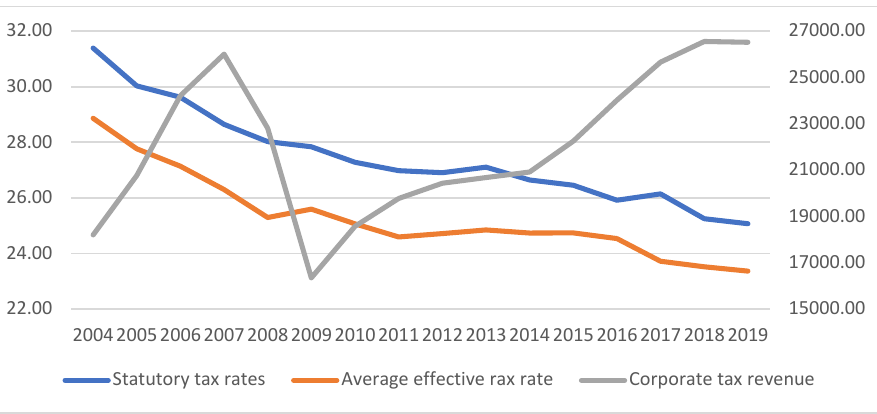
Figure 1. Average value of tax rates and corporate tax revenues in the old EU member states for the period from 2004 to 2019. Source: own processing according to European Commission (2021).